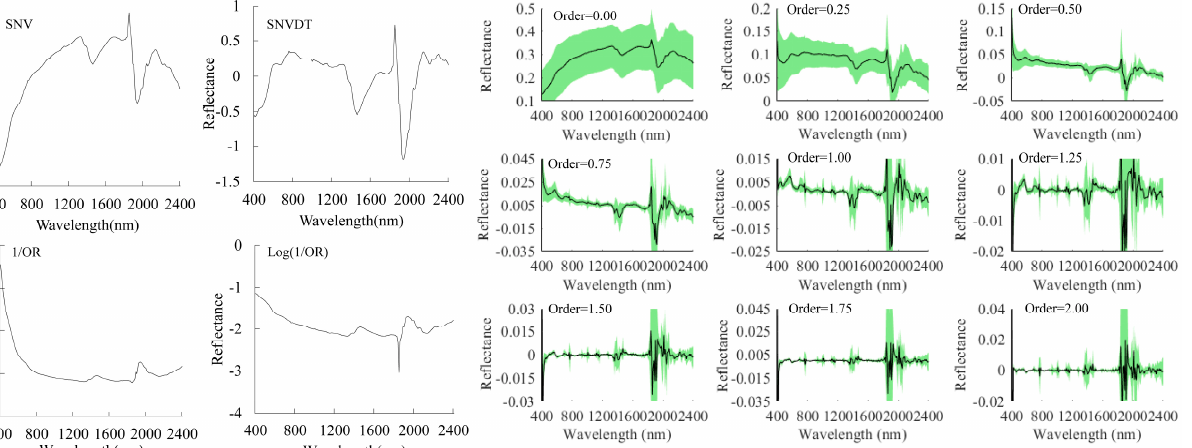
Figure 2. Hyperspectral reflectance of the soil measured on the ground under different saline levels